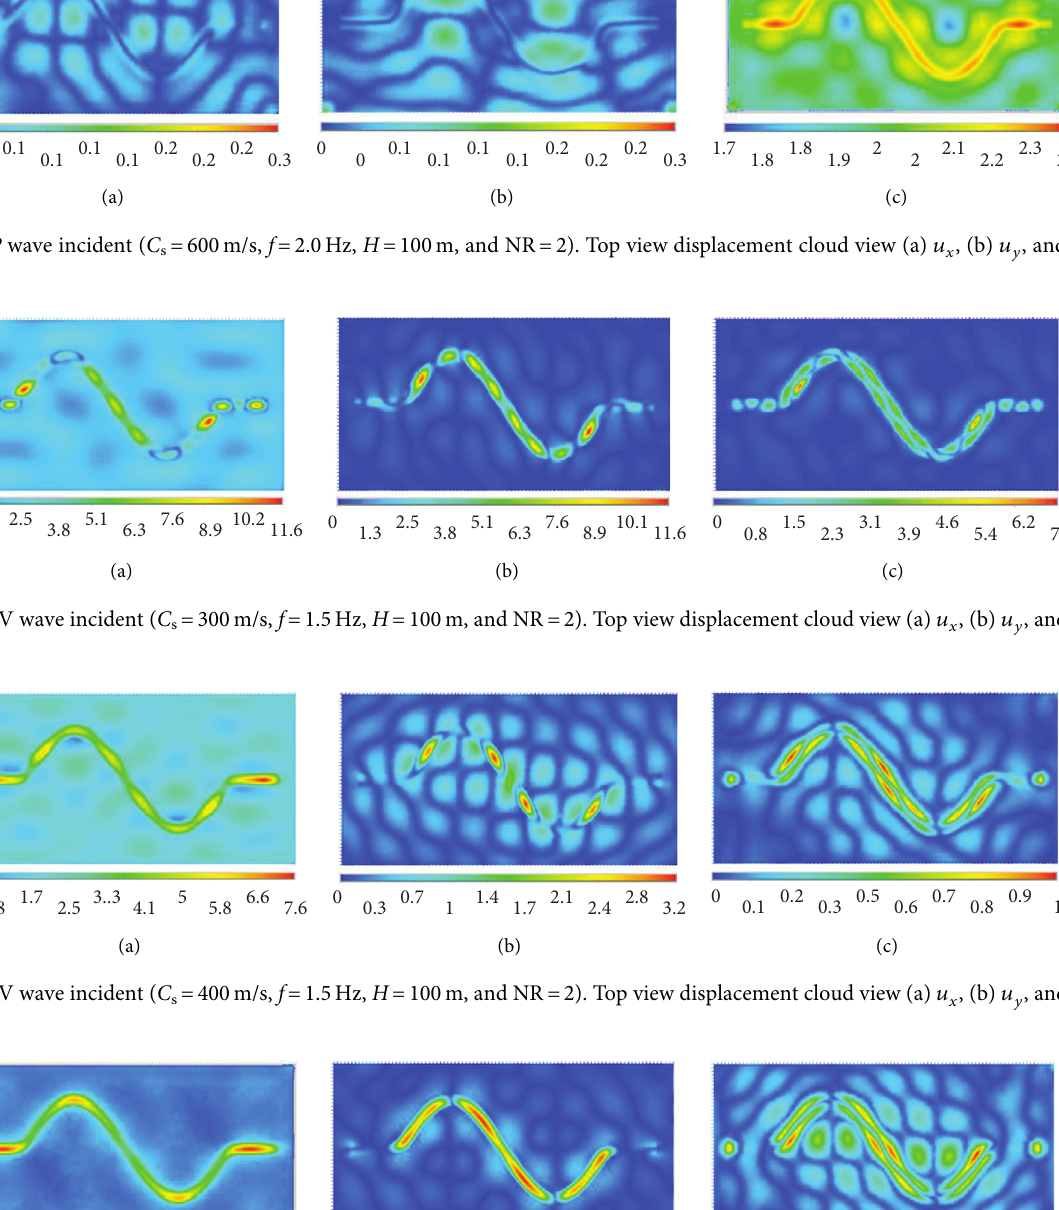
� 500m/s, f � 1.5Hz, H � 100m, and NR � 2). Top view displacement cloud view (a) u s